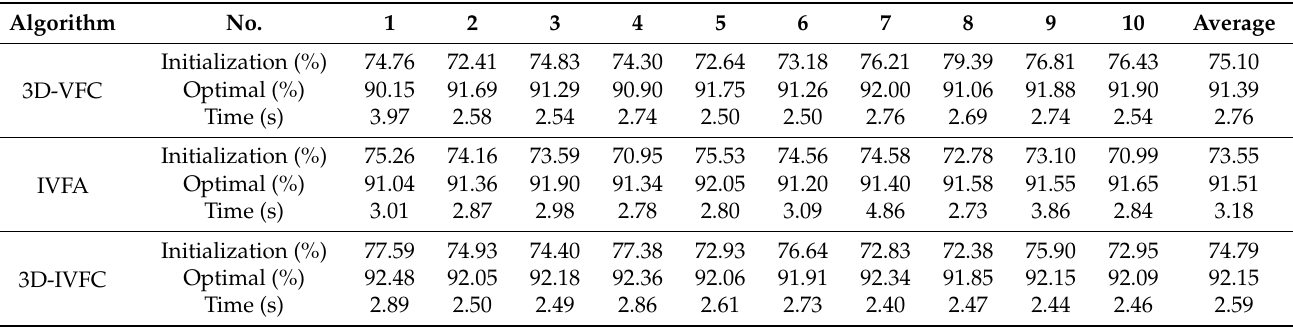
Table 2. Algorithm comparison of random node coverage results.